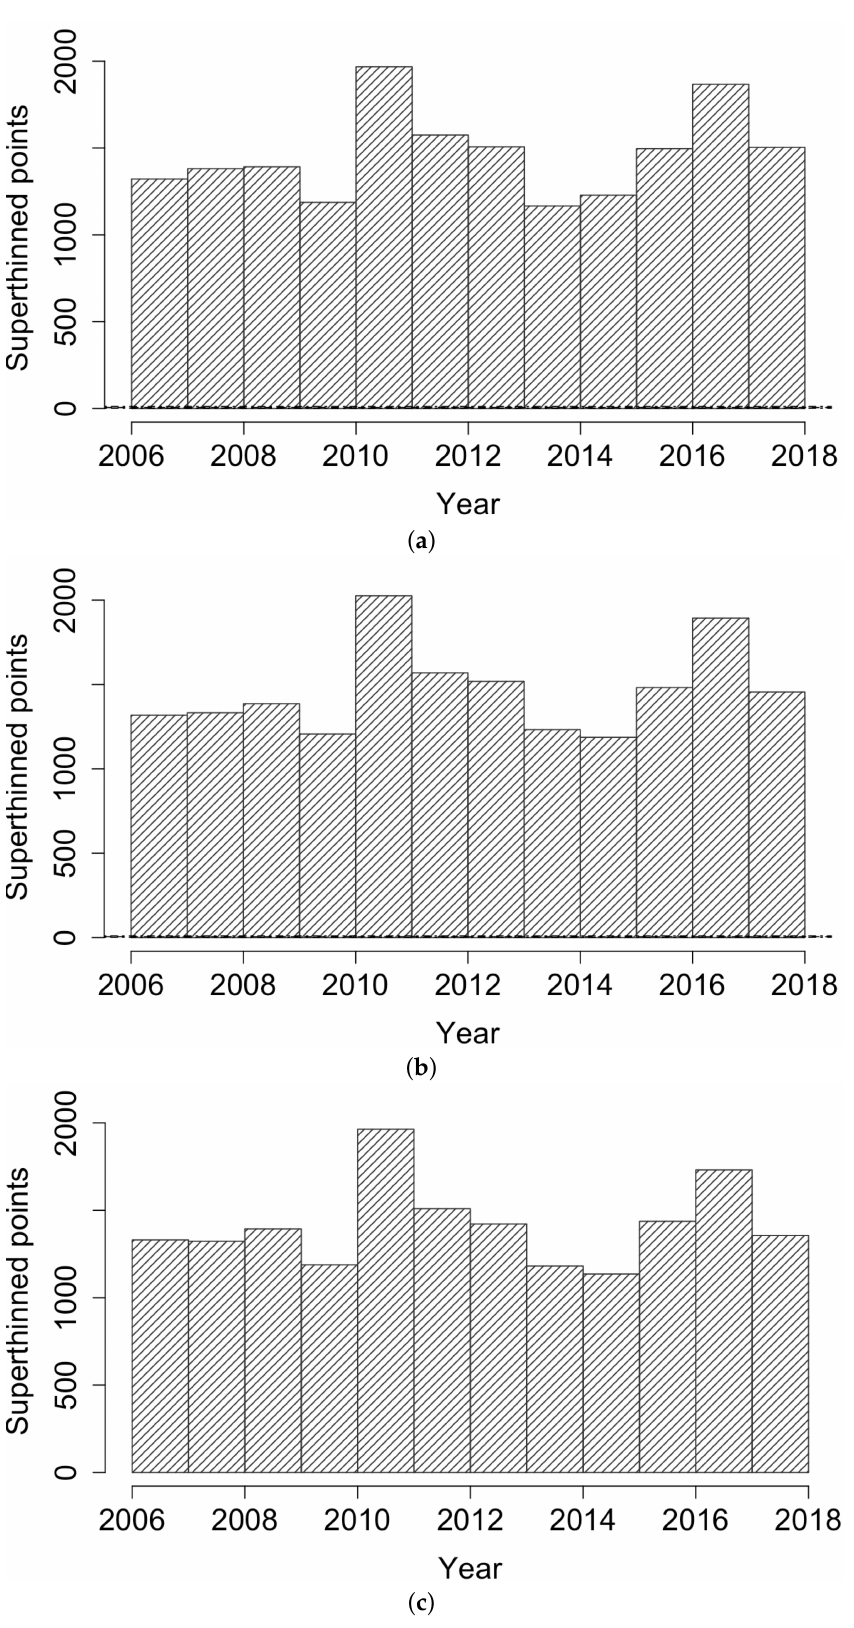
Figure 4. Histograms of superthinned residuals for ( a ) the Hawkes model with power law triggering, ( b ) the Hawkes model with exponential triggering, and ( c ) the recursive